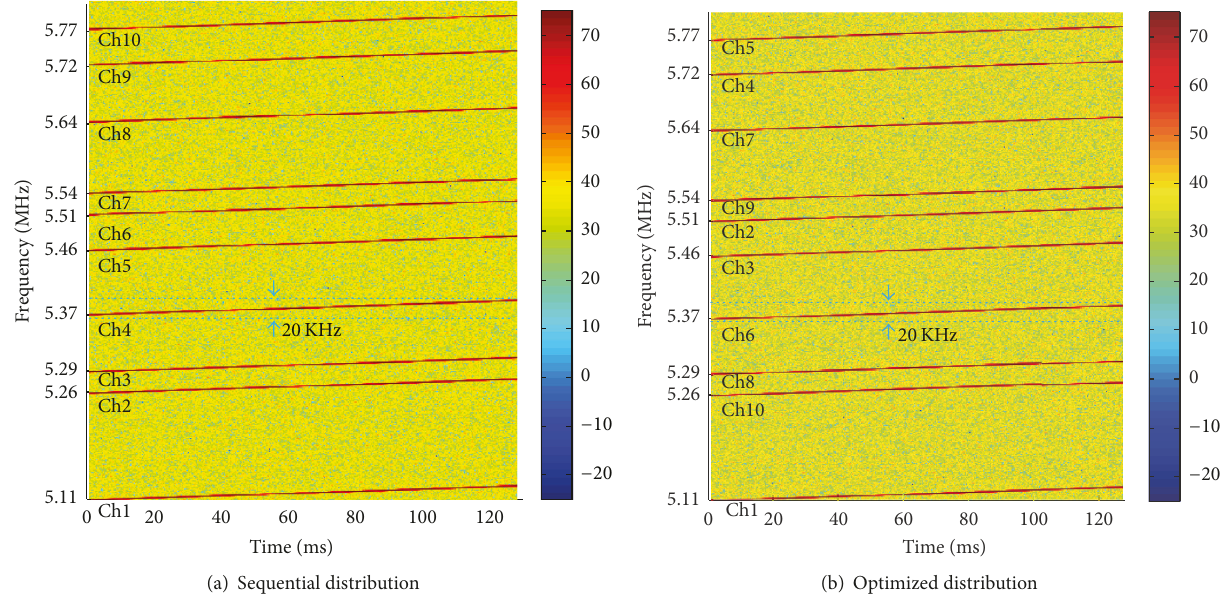
Figure 6: Time-frequency characteristic of the transmitted signals (short-time Fourier transform (STFT) applied to the transmitted signals).